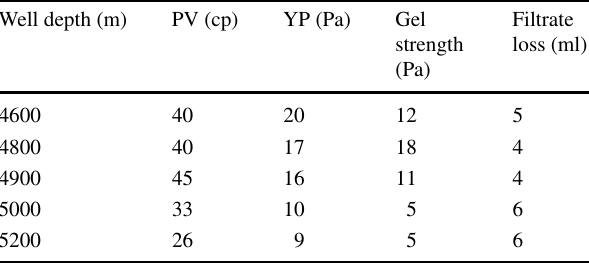
Table 9 Mud properties at various depths